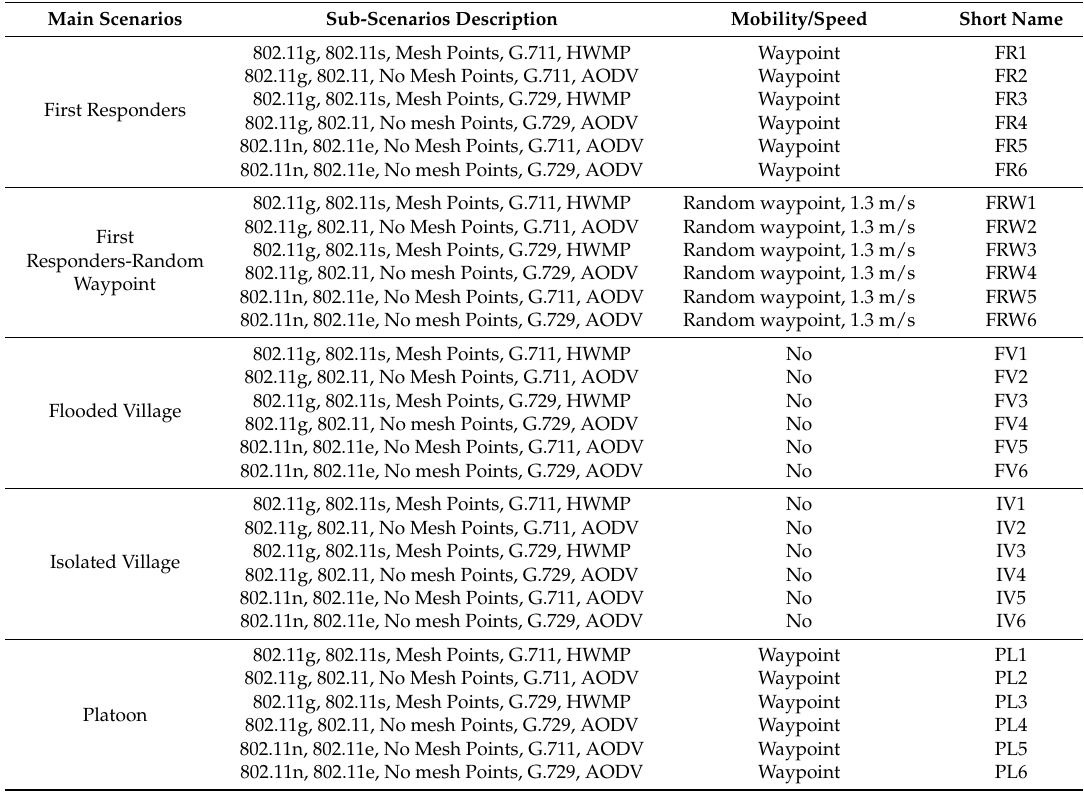
Table 3. Main and